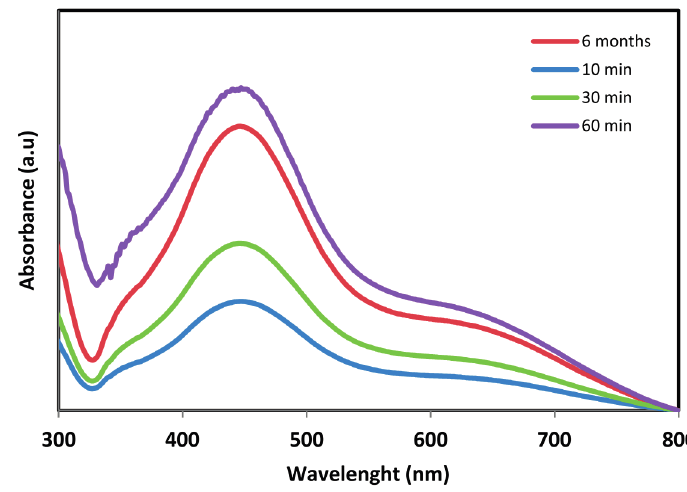
Figure 2. UV-visible spectra of bio-synthesized Ag-NPs.